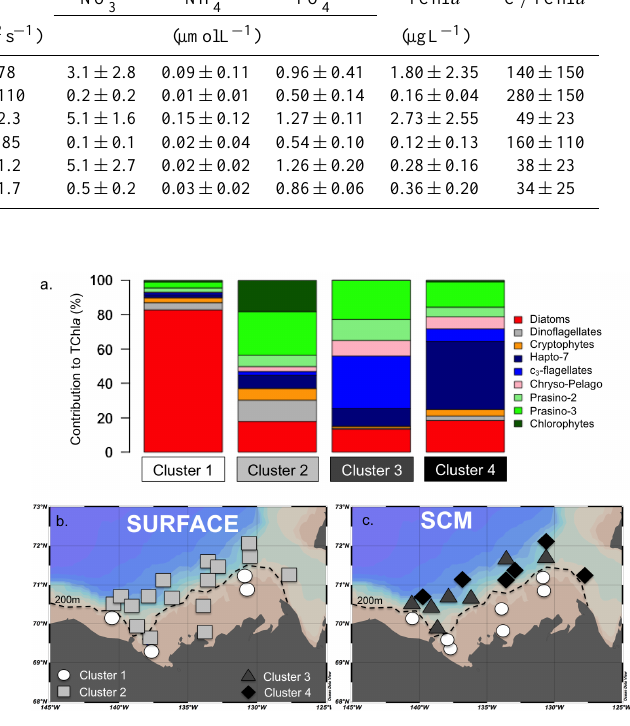
Figure 3. Average contribution of major algal groups to total chlorophyll a (Chl a ) concentration at the subsurface chlorophyll maximum (SCM) depth in the deep waters of the Beaufort Sea calculated with the CHEMTAX software using five different pig- ment / Chl a ratio matrices. Ratio matrices are from previous stud- ies conducted in polar oceans: Vidussi et al. (2004) in the North Wa- ter Polynya, Suzuki et al. (2002) in the Bering Sea, Not et al. (2005) in the Barents Sea, Rodriguez et al. (2002) around the Antarctic Peninsula and Wright et al. (1996) in the Southern Ocean. Accord-